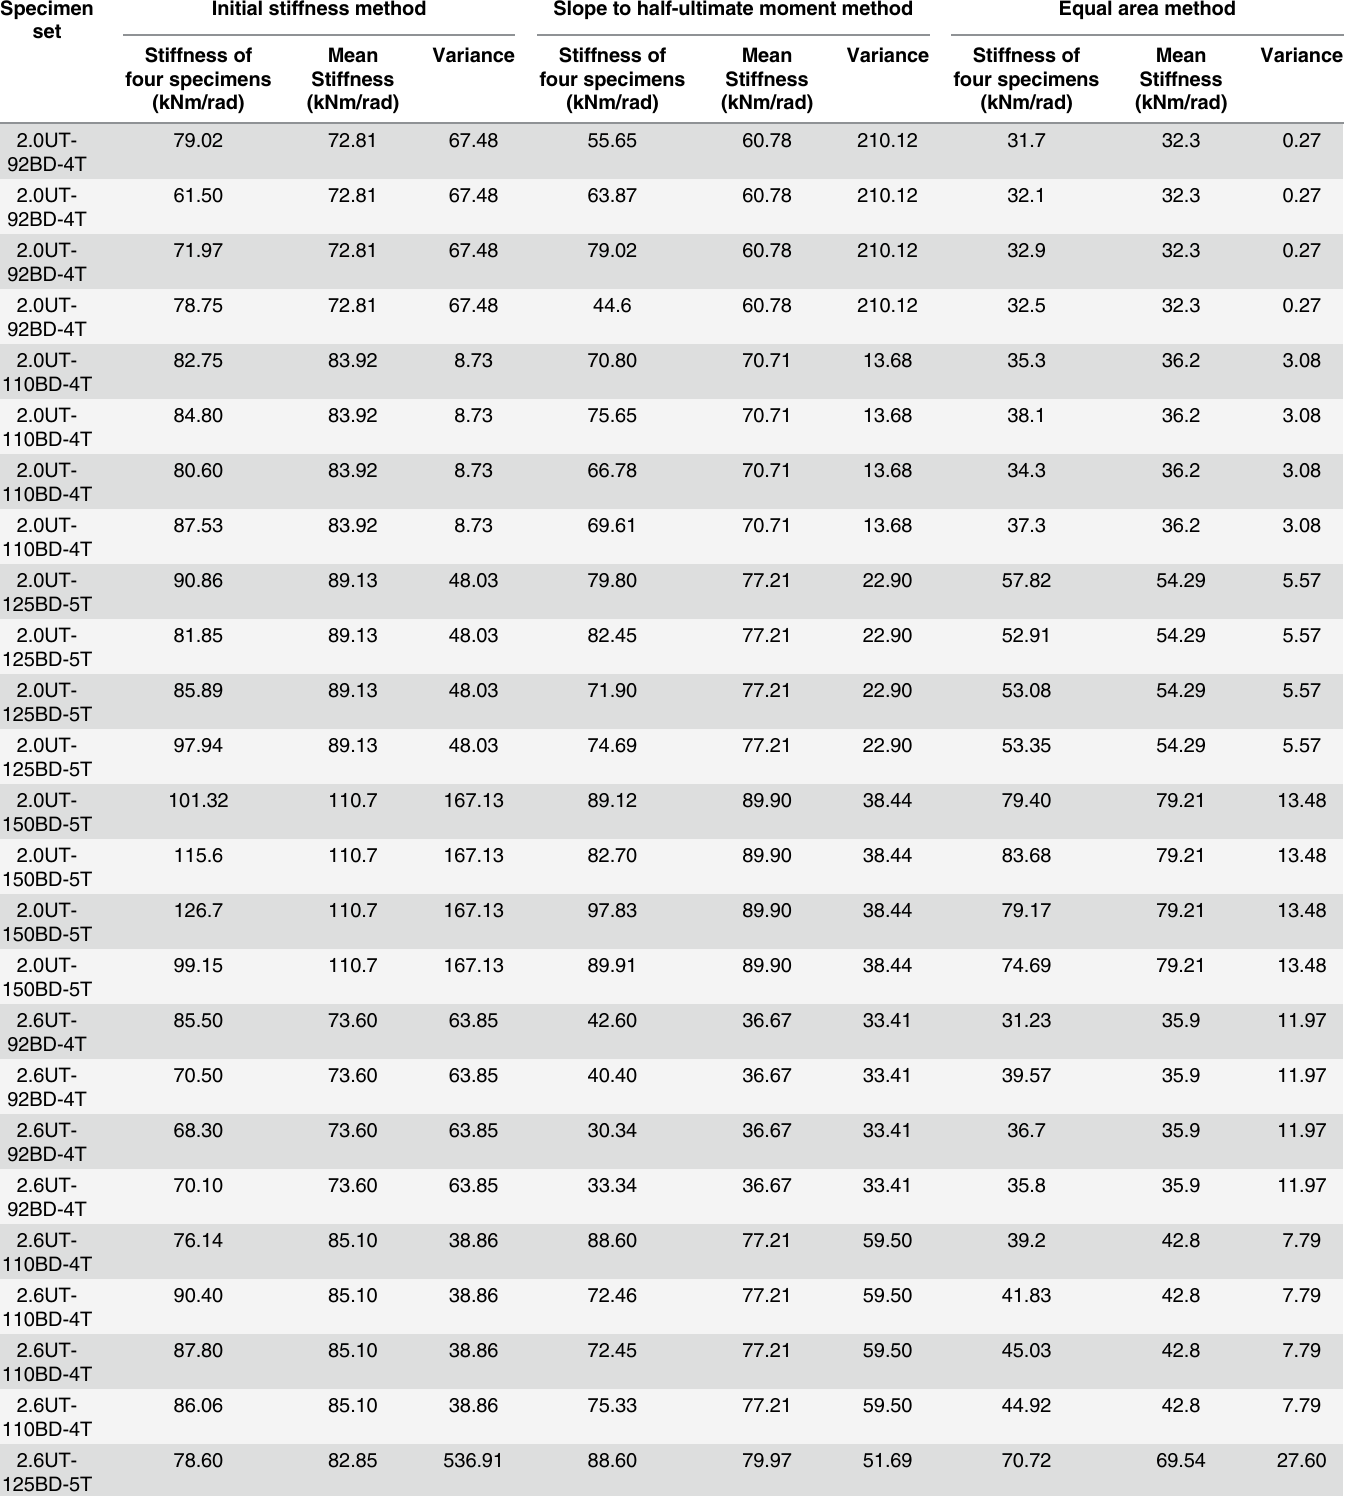
Table 6. Comparison of the Initial stiffness, Slope to half-ultimate moment and equal area methods. Specimen